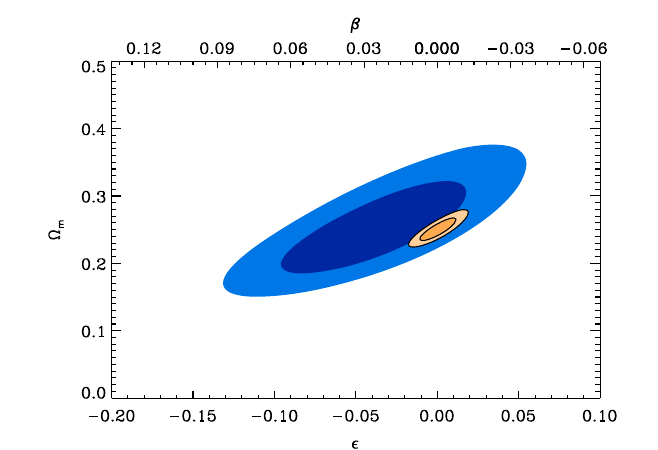
Fig. 54 Constraints on possible violation of the Etherington relation in the form of deviations from a perfectly transparent universe ( (cid:30) = 0). The corresponding constraint on the parameter β , quantifying violations from the standard temperature-redshift relation, can be read in the upper x-axis. Blue regions represent current constraints while orange are forecast Euclid constraints assuming it is accompanied by a